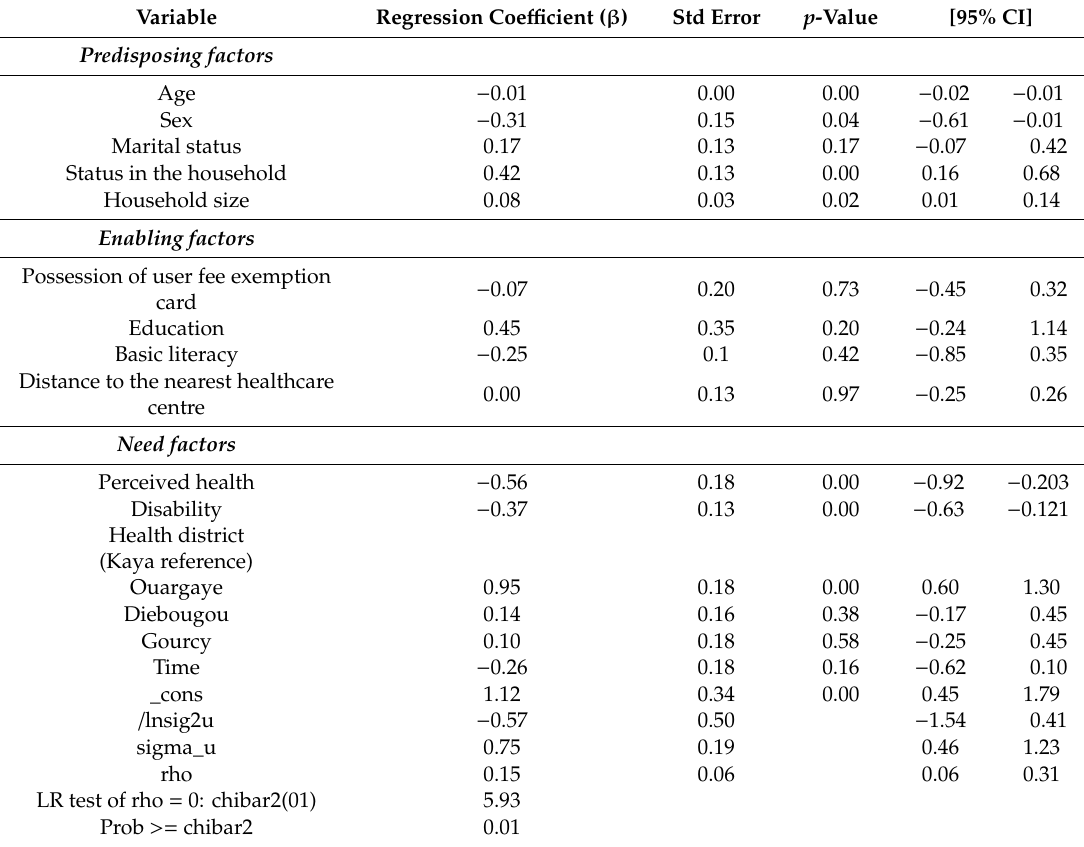
Table 5. Regression model on service use (conditional upon reporting